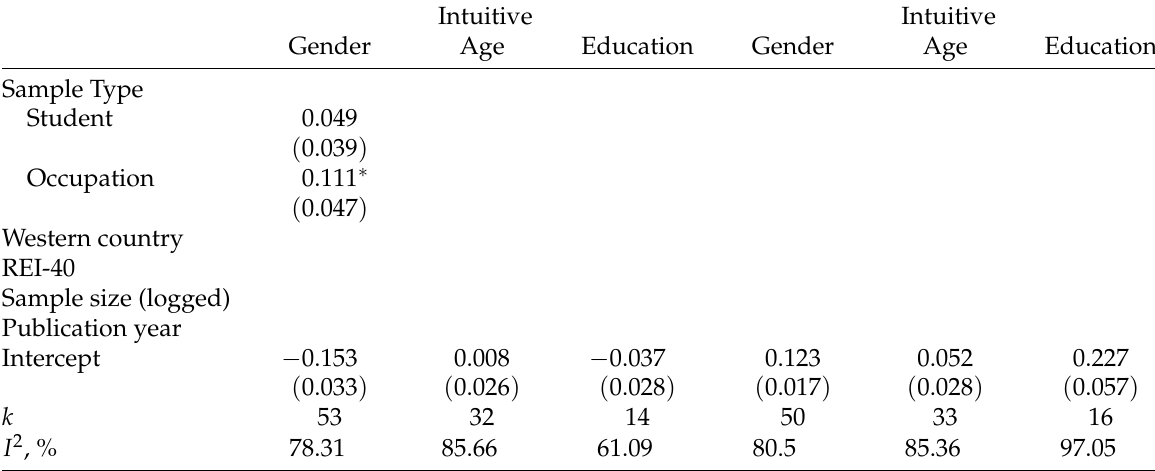
Table 3: Moderators of Heterogeneity in Effects of Demographic Predictors on Intuitive Cognitive